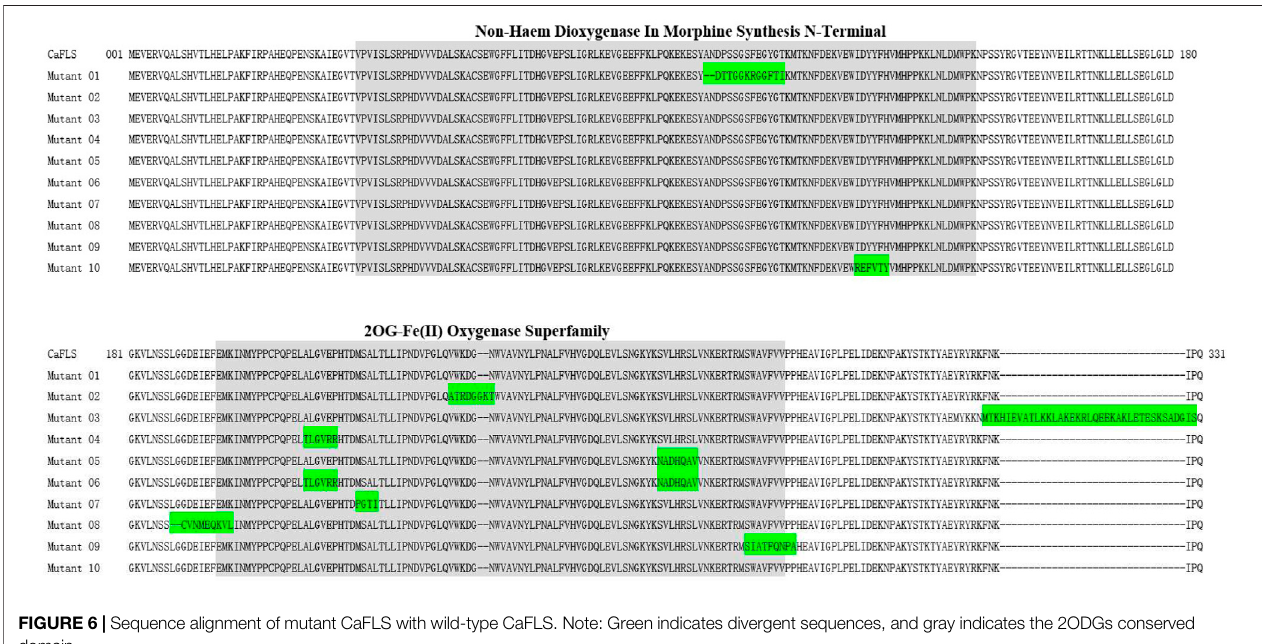
FIGURE 6 | Sequence alignment of mutant CaFLS with wild-type CaFLS. Note: Green indicates divergent sequences, and gray indicates the 2ODGs conserved domain.